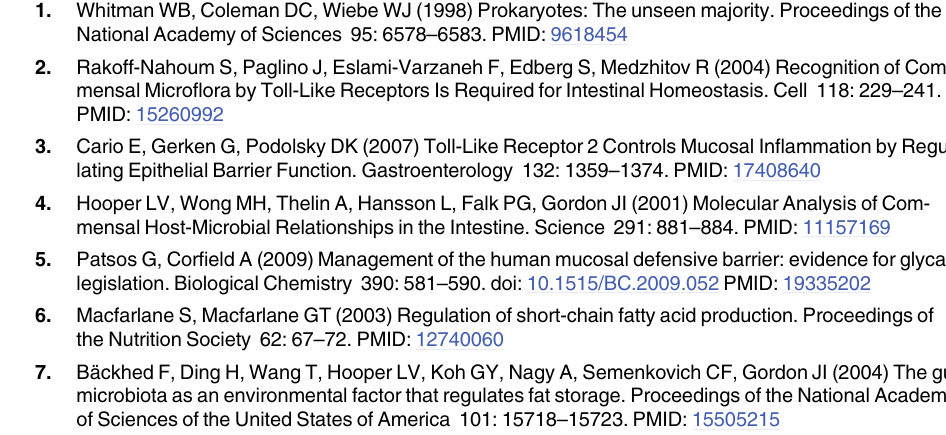
S1 Fig. Euler diagrams for functional GO analysis of ileum microarray representing devel- opment- and microbial colonization- effects in GF and SPF mice. S1A: Area-proportional Euler diagram of development-associated-genes generated from differentially expressed genes in post vs preweaned GF and SPF ileum (minimum total number of genes per category: 100; max p-value: 0.025) is shown. A total of 10 ontology categories were significantly enriched among the changed genes. The analysis revealed that those categories strongly overlap with metabolic process-related categories. S1B: Area-proportional Euler diagram of microbial- colonization-associated-genes generated from differentially expressed genes in SPF vs GF ileum. A total of 8 ontology categories were significantly enriched. The analysis revealed that the categories strongly overlap into 2 major categories: cytokine biosynthesis and innate im- mune response-NF- κ B signaling. S2 Fig. Larger format of Fig 3C. Overrepresentation of inflammatory response-related net- works in common differentially expressed microbial-associated-genes in M -H_GF (154 genes) by Ingenuity Pathway Analysis (IPA). Orange line: activation; Blue vs M PI line: inhibition; Grey: not present. (TIF) S3 Fig. Fig 6C with additional weight information for GF and SPF. Growth curve of M -H (n = 15), GF (n = 9) and SPF (n = 9) from birth to weaning. The daily weights (n = 20), M PI are presented as mean (g) ± SEM. One-way ANOVA with post-hoc Tukey ’ s HSD test was used to compare the